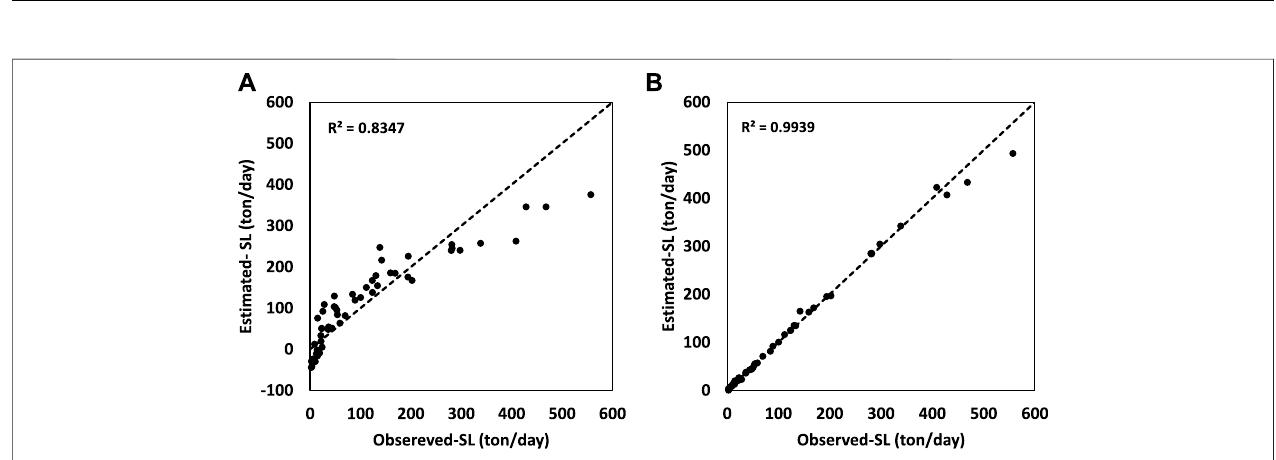
Frontiers in Environmental Science |